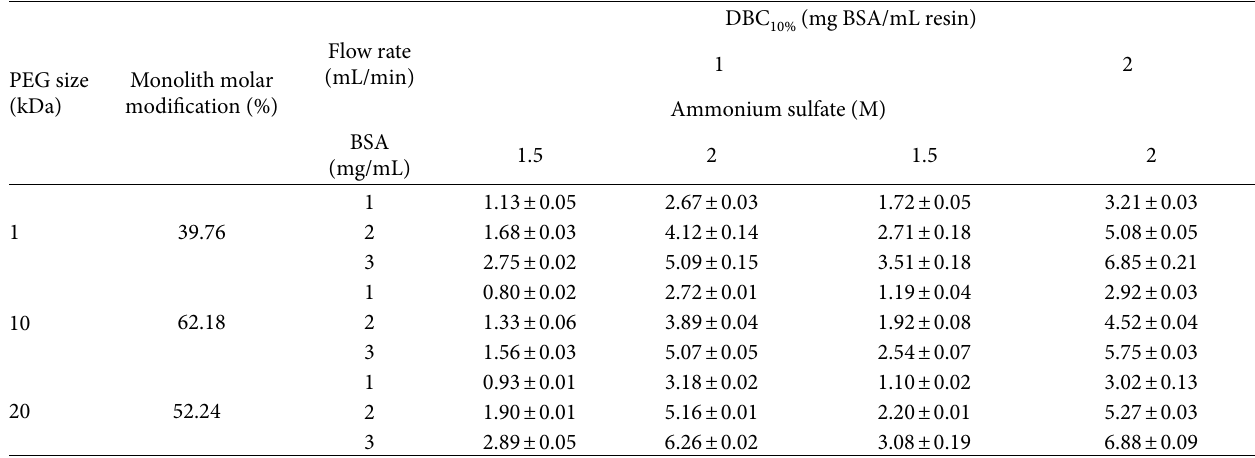
Data of DBC presented represents the mean of three runs and their standard 10%